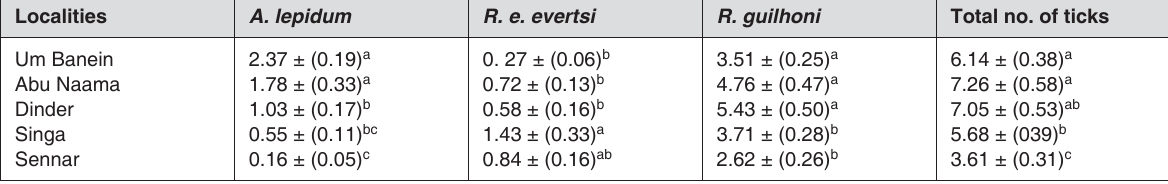
TABLE 1 Mean (± SE) numbers of ticks collected from sheep at different localities in Sennar State, Sudan during 2002–2003 Localities